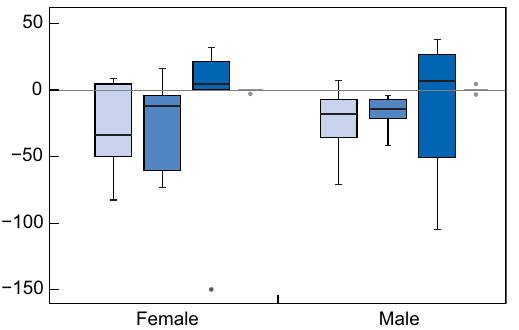
Figure 1: Box plot of relative change of FEV1 (light blue), FEF25/75 (medium blue), BMI Z-score (dark blue) and height according to gender.